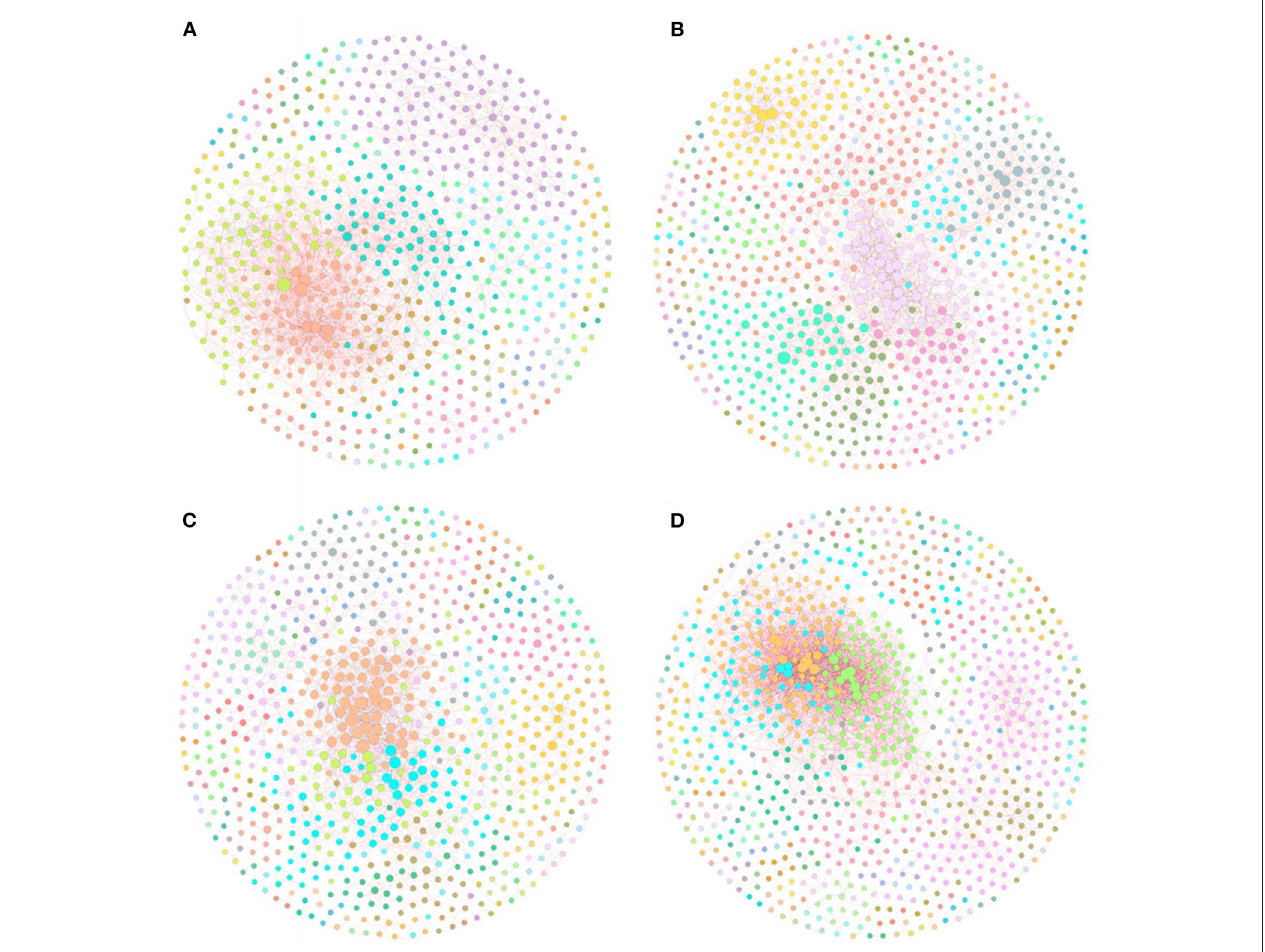
FIGURE 5 | The RMT-based molecular ecological networks of CK (A) , Y10 (B) , Y20 (C) , Y40 (D) . In the networks, each node represents an OUT, and edges between nodes correspond to either positive (red) or negative (black) correlations. Modules were randomly colored.